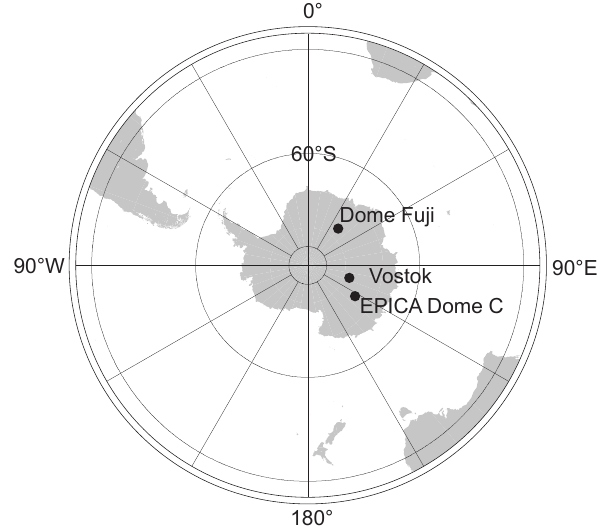
Fig. 1. Locations of the Antarctic ice cores used in this